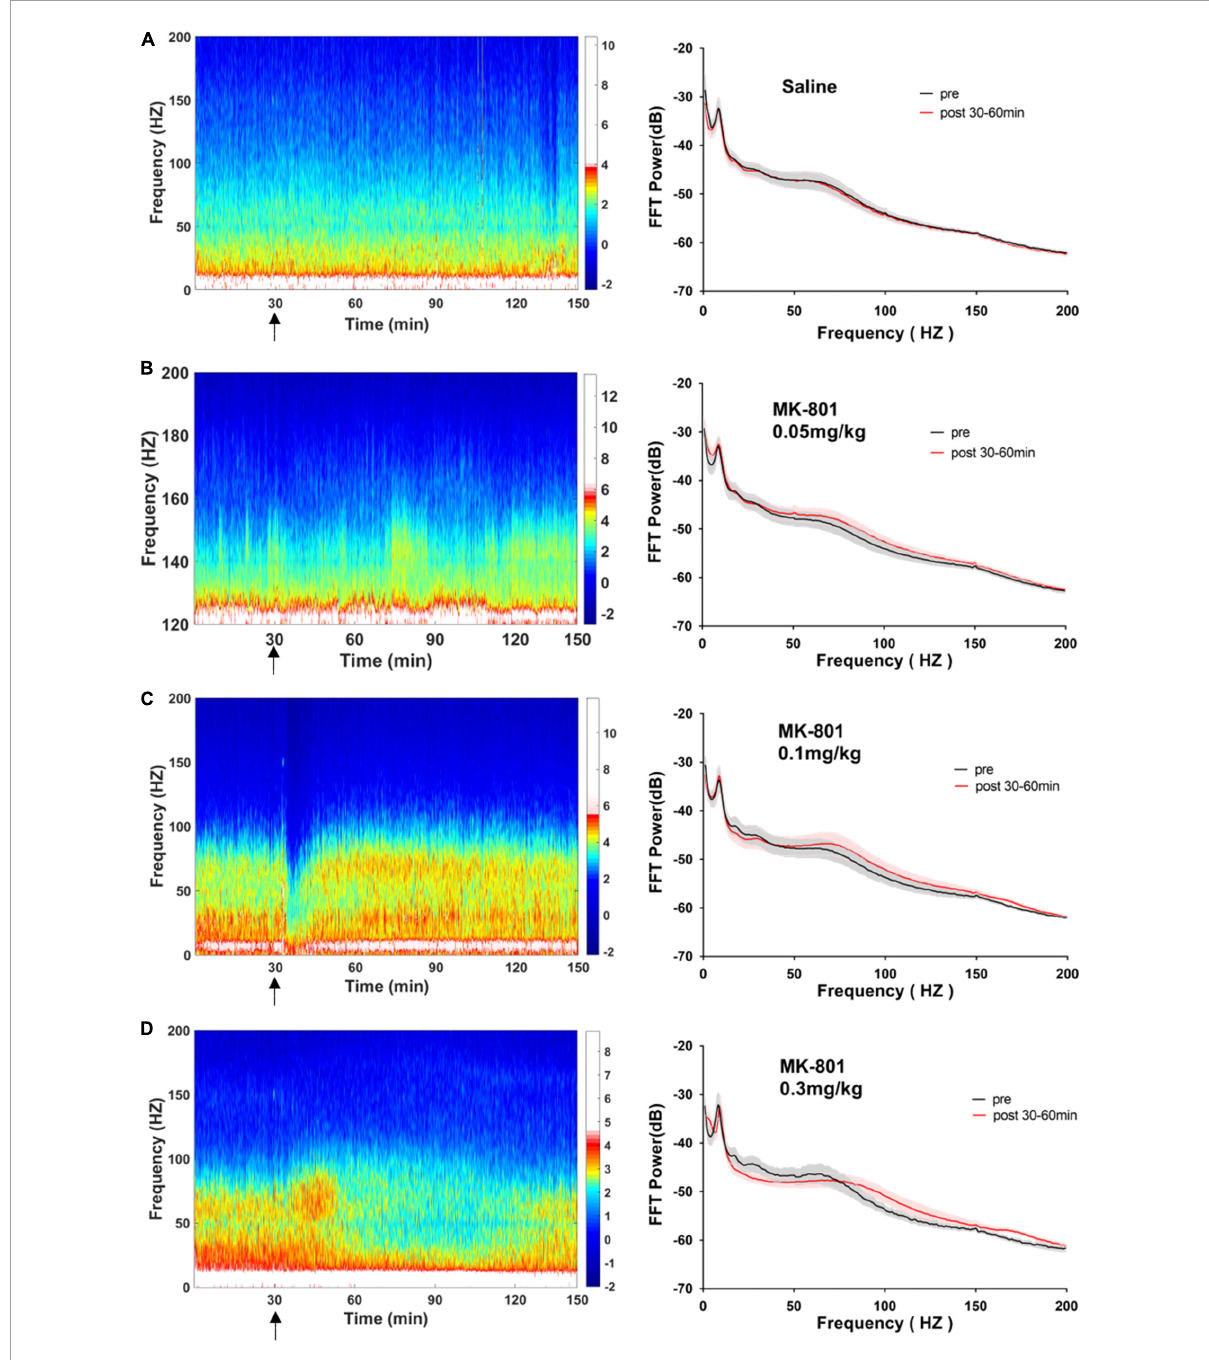
FIGURE6 Effects of MK-801 on LFP in the CA1 of hippocampus. The same format as Figure 4 .